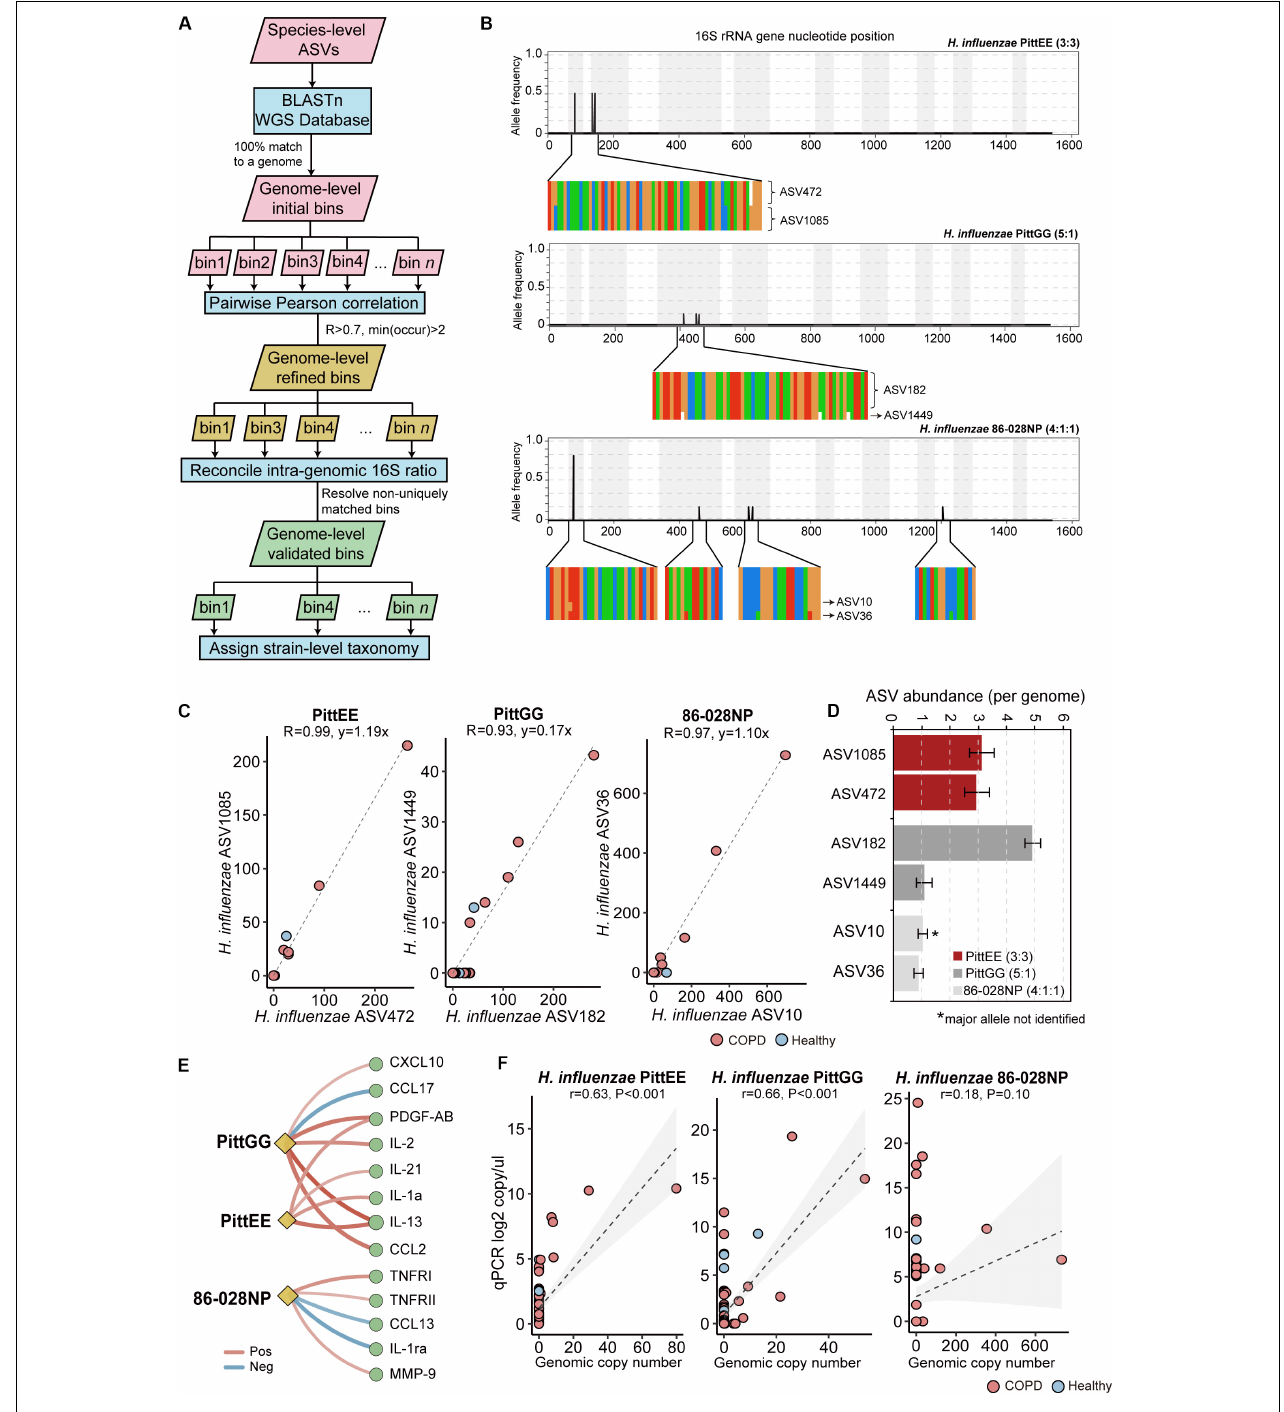
FIGURE 4 | Strain-level identification in the airway microbiome. (A) The designed pipeline for identifying strain-level ASV bins. (B) The polymorphism in the 16S rRNA gene sequences for H. influenzae PittEE, PittGG and 86-028NP strains. The position and frequency of substitution in the full-length 16S sequences of the three strains were shown. The magnified regions showed respective positions in the alignment of all six copies of 16S gene in the corresponding H. influenzae genomes. The genuine ratios of 16S allelic variants in the three genomes are: 3:3, 5:1 and 4:1:1. (C) The correlation pattern between the counts for pairs of ASVs assigned to the strains PittEE, PittGG and 86-028NP (Pearson’s R > 0.93). (D) The copy number of the highly-correlated ASVs are in integral ratio with the genuine allelic frequency of the 16S rRNA genes within the genome. The major 16S allele of the 86-028NP strain was not detected. (E) Significant associations between the three H. influenzae strains with sputum mediators (Spearman, FDR P < 0.05). (F) qPCR results using strain-specific primers for the three H. influenzae strains in relation to their relative abundances in the sequencing